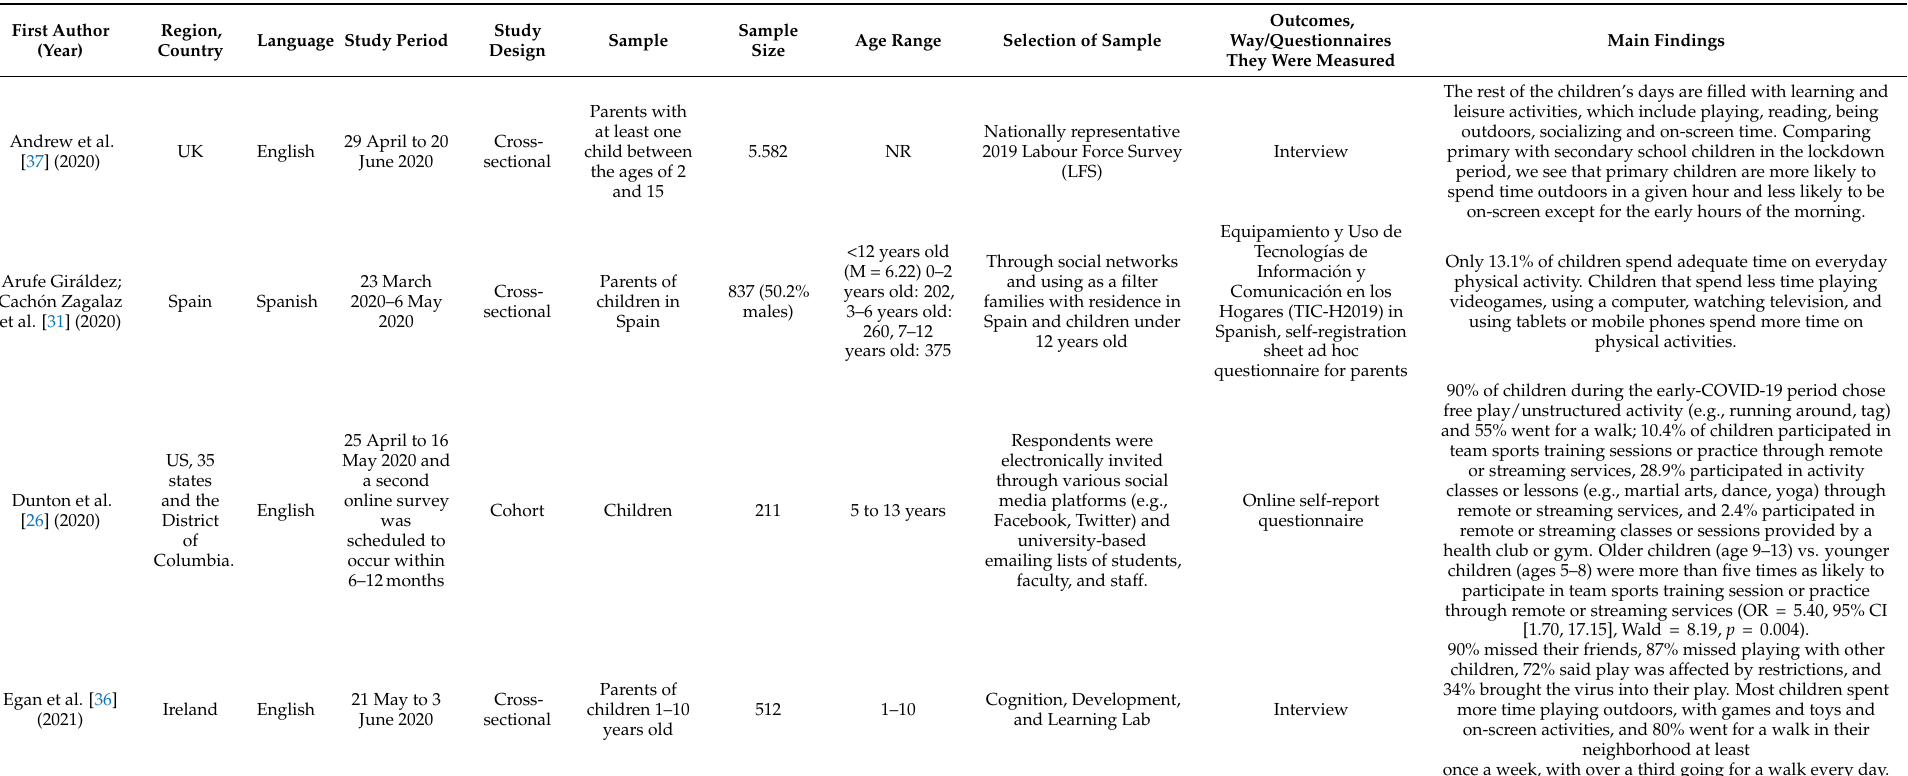
Table 1. Descriptive characteristics of included